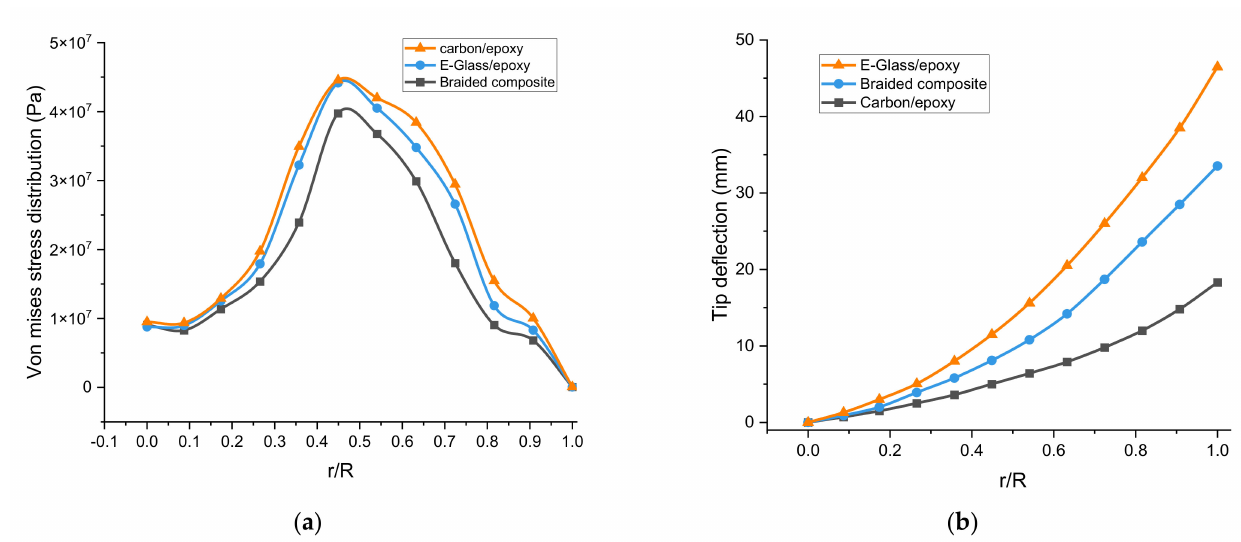
Figure 12. Variations of ( a ) Von mises stress and ( b ) tip deflection along the blade.